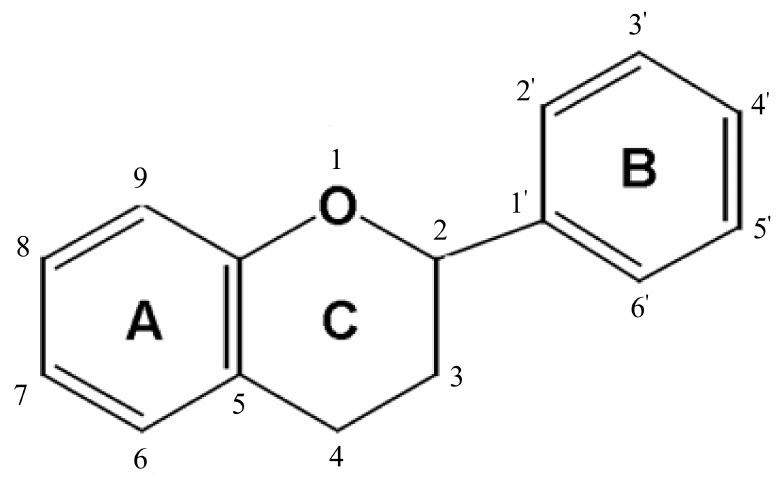
Figure 1. General structure of